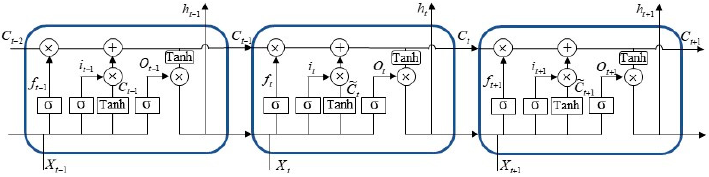
Figure 4. Long short-term memory (LSTM) structure